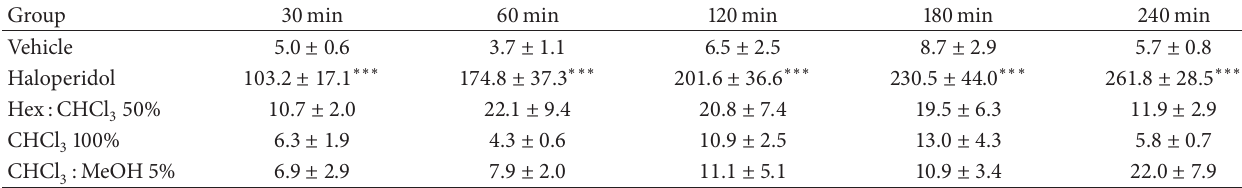
50%, CHCl 100%, and CHCl 3 3